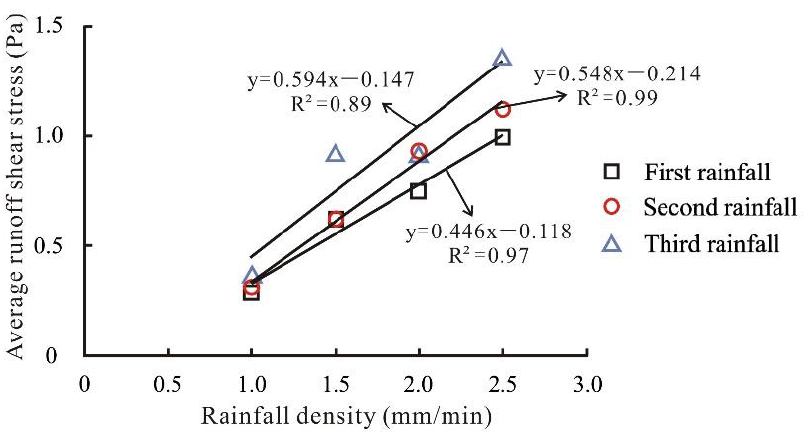
Figure 17. Linear fitting relationship between average runoff shear stress and rainfall density of the sand-covered slope.